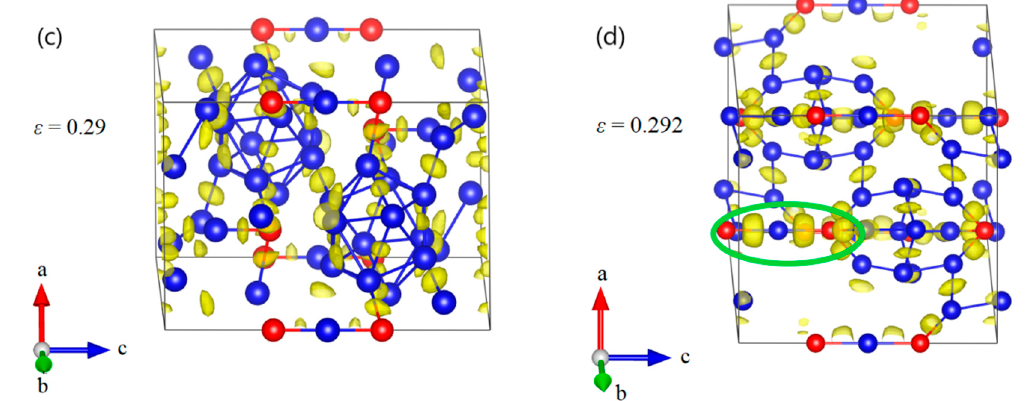
Figure 5. The structural changes and electron localization function (ELF) at various critical strains for B 12 –CBC structure under c axis compression: ( a ) the undeformed structure; ( b ) the structure at ε = 0.24 relating to the maximum stress; ( c ) the structure at ε = 0.29 before structural failure, where the chains are still straight and the icosahedra are intact; ( d ) the structure at ε = 0.292 where the structure fails because the icosahedra are fully destroyed without bending the C–B–C chains (Blue = B atoms; red = C atoms).